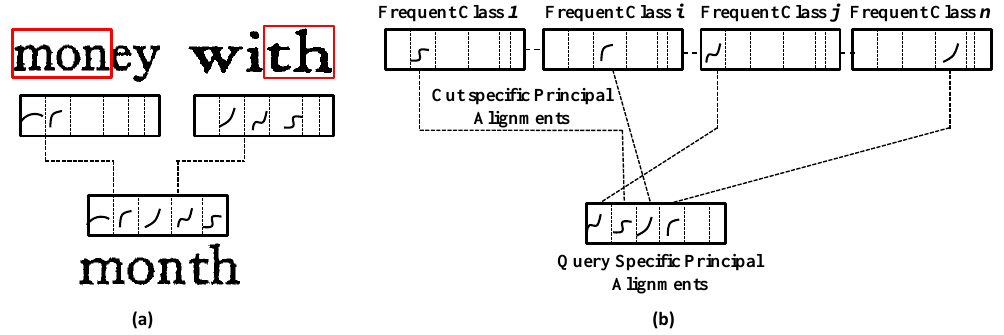
Figure 4. Synthesis of query specific principal alignments. ( a ) Cut specific principal alignments corresponding to “ground” and “leather” are joined to form the principal alignments for “great”. Note that the appropriate cut portions are automatically found. ( b ) In a general setting, query specific principal alignments gets formed from multiple constituent cut specific principal alignments computed for frequent